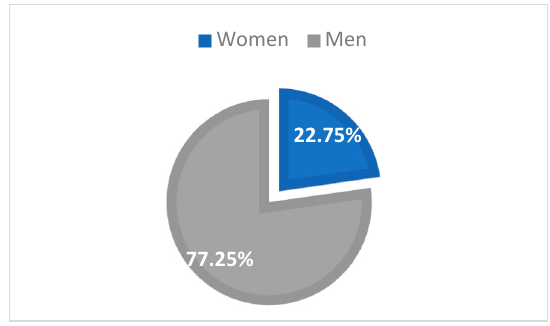
Figure 1. Distribution of new HIV/AIDS cases by sex.